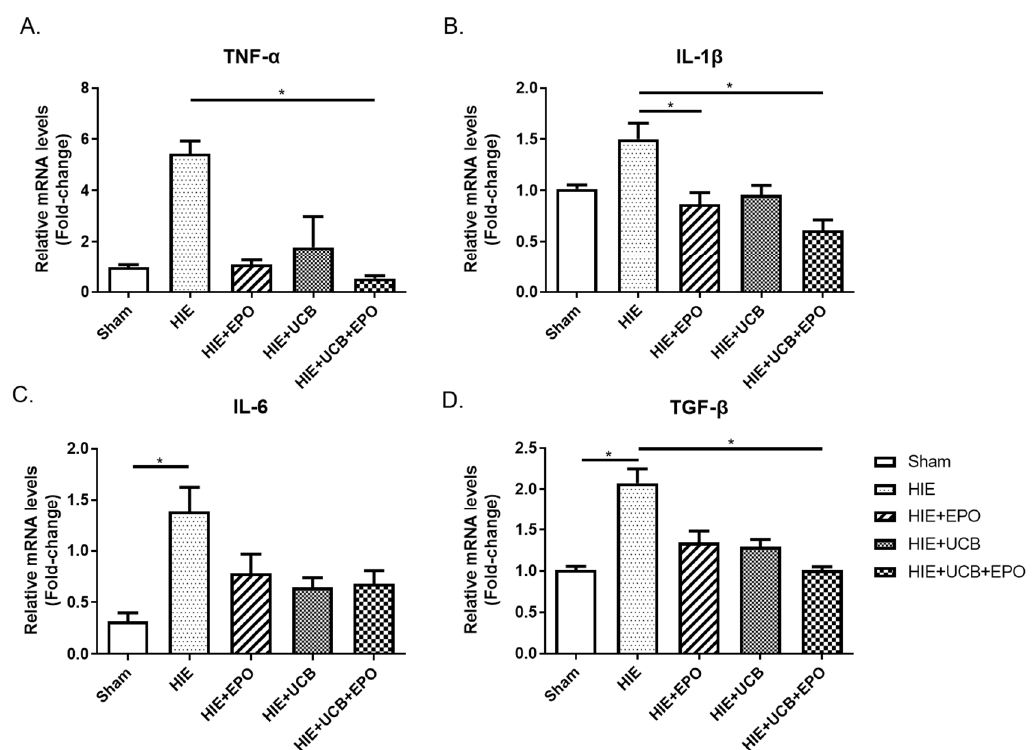
Figure 3. Pro-inflammatory cytokine gene expression was decreased in each treatment group. ( A – D ) The mRNA expression of pro-inflammatory cytokines (TNF- α , IL-1 β , and IL-6) and TGF- β was detected by qRT-PCR. Data shown as the mean ± standard error of mean. n = 4 to 6 per group, * p < 0.05 (Kruskal–Wallis).